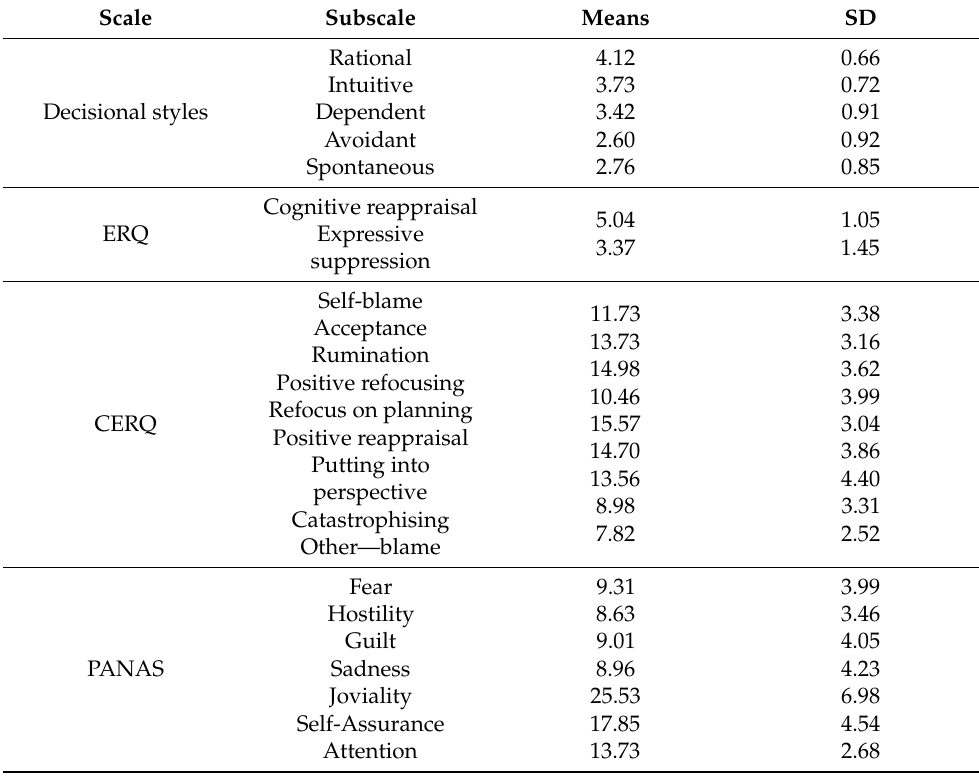
Table 1. Means and standard deviations of the study variables.